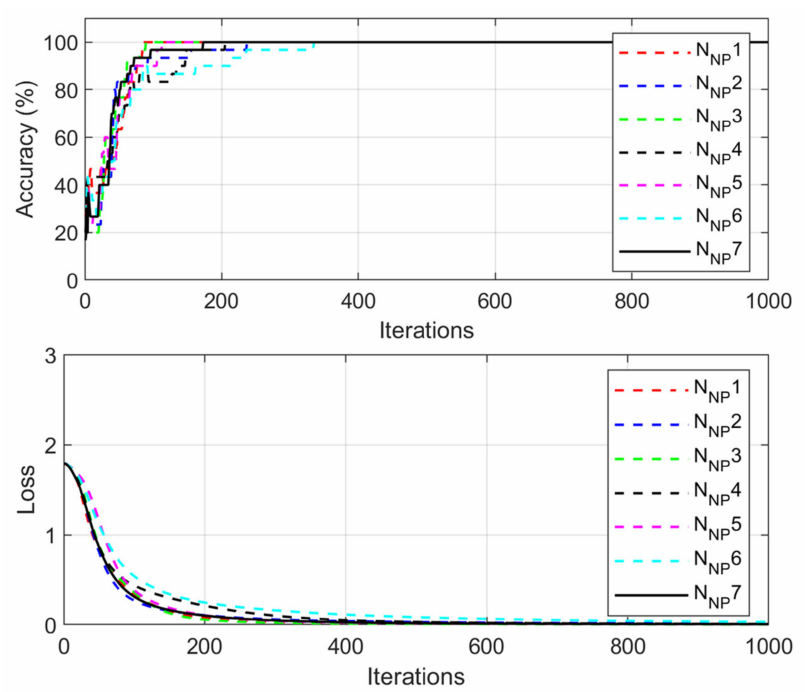
Figure A4. Training process and detection results of the 7 CNNs.